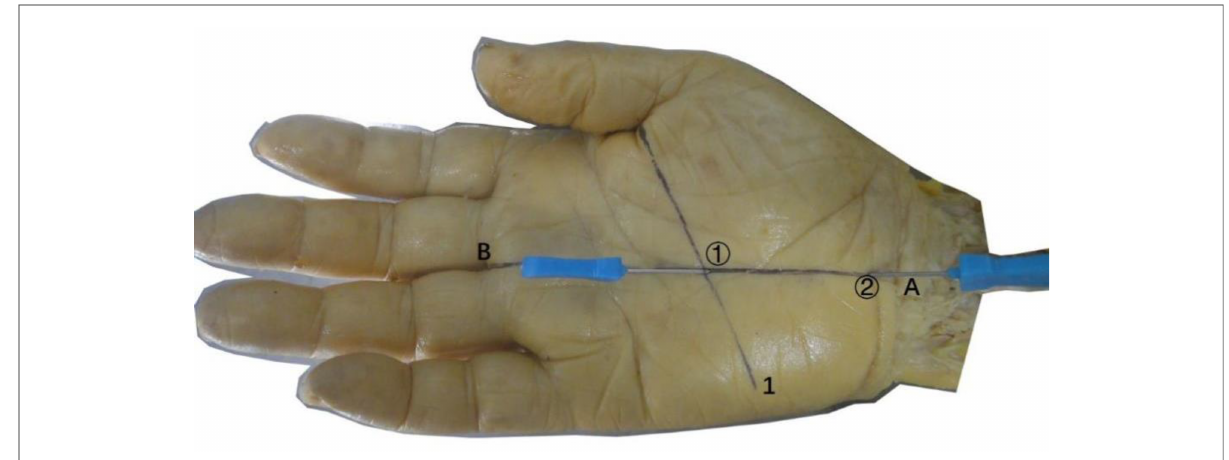
FIGURE 8 The completed needle insertion technique of the non-ultrasonic guided needle knife release technique. ① , needle entry point 1; ② , needle entry point 2; 1, Kaplan line; ( A ) the intersection point of the palmar longus tendon with 3 mm lateral to the ulnar side and the transverse stripes of the proximal wrist; ( B ) the intersection of the ring fi nger and the middle fi